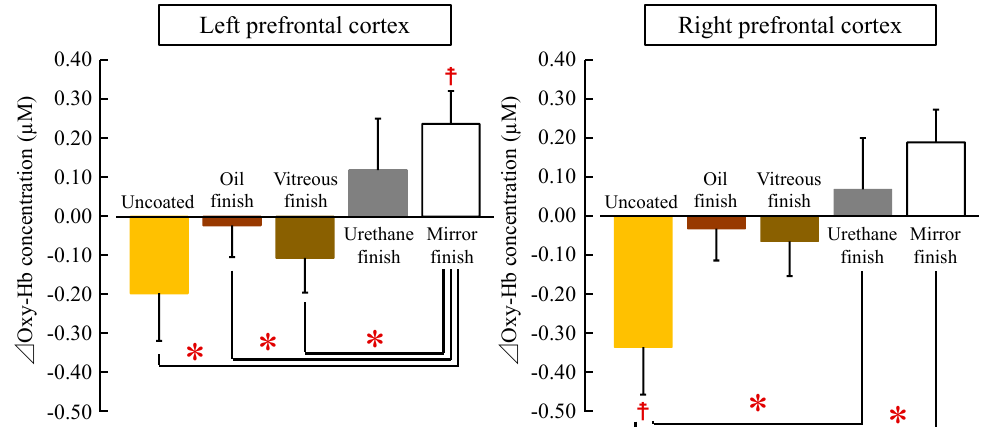
Figure 5. Overall mean oxy-Hb concentrations in the left and right prefrontal cortices while touching white oak wood (uncoated, oil finish, vitreous finish, urethane finish, and mirror finish). Data are expressed as mean ± standard error. n = 18,